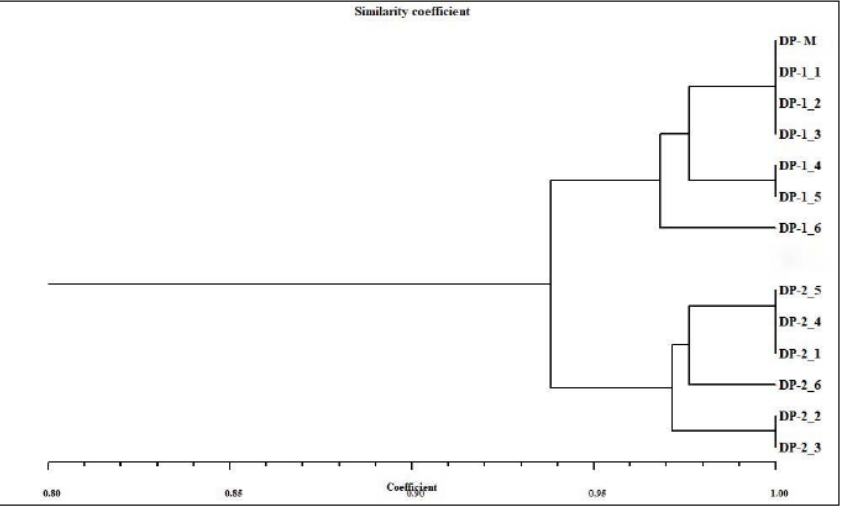
Figure 10. Dendrogram of SCoT analysis depicting the genetic similarity between the mother plant (DP-M) and the in vitro regenerated plants of D. purpurea .